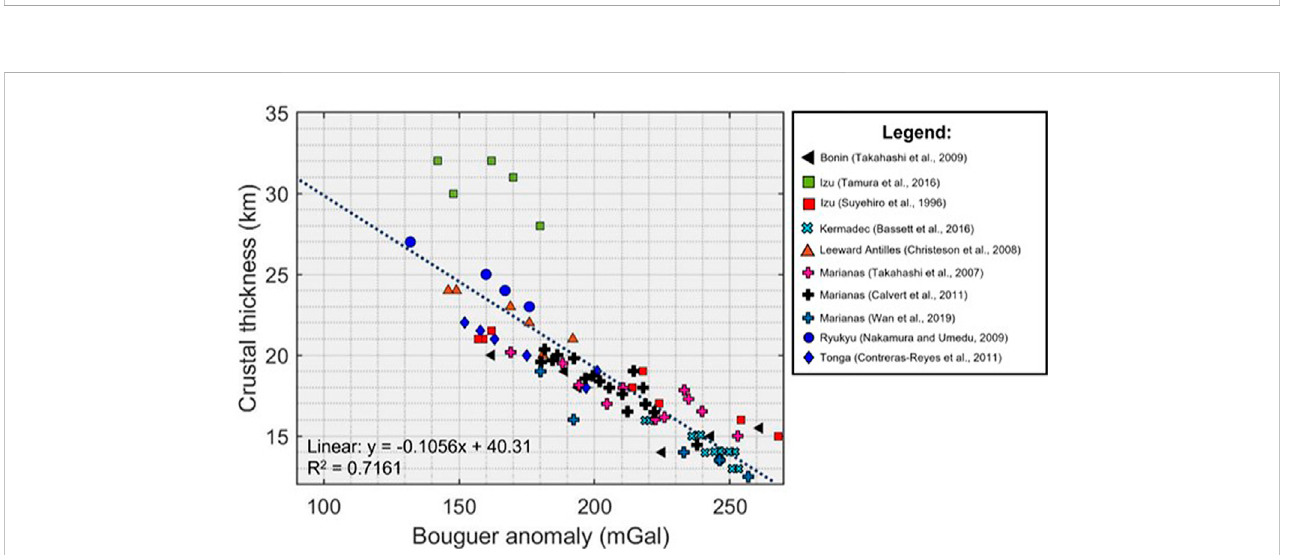
FIGURE 2 Crustal thickness vs. Bouguer anomaly plot for all the arc datasets utilized in this study. A strong negative correlation exists between the two variables as represented by the negative regression curve and a high coef fi cient of correlation at